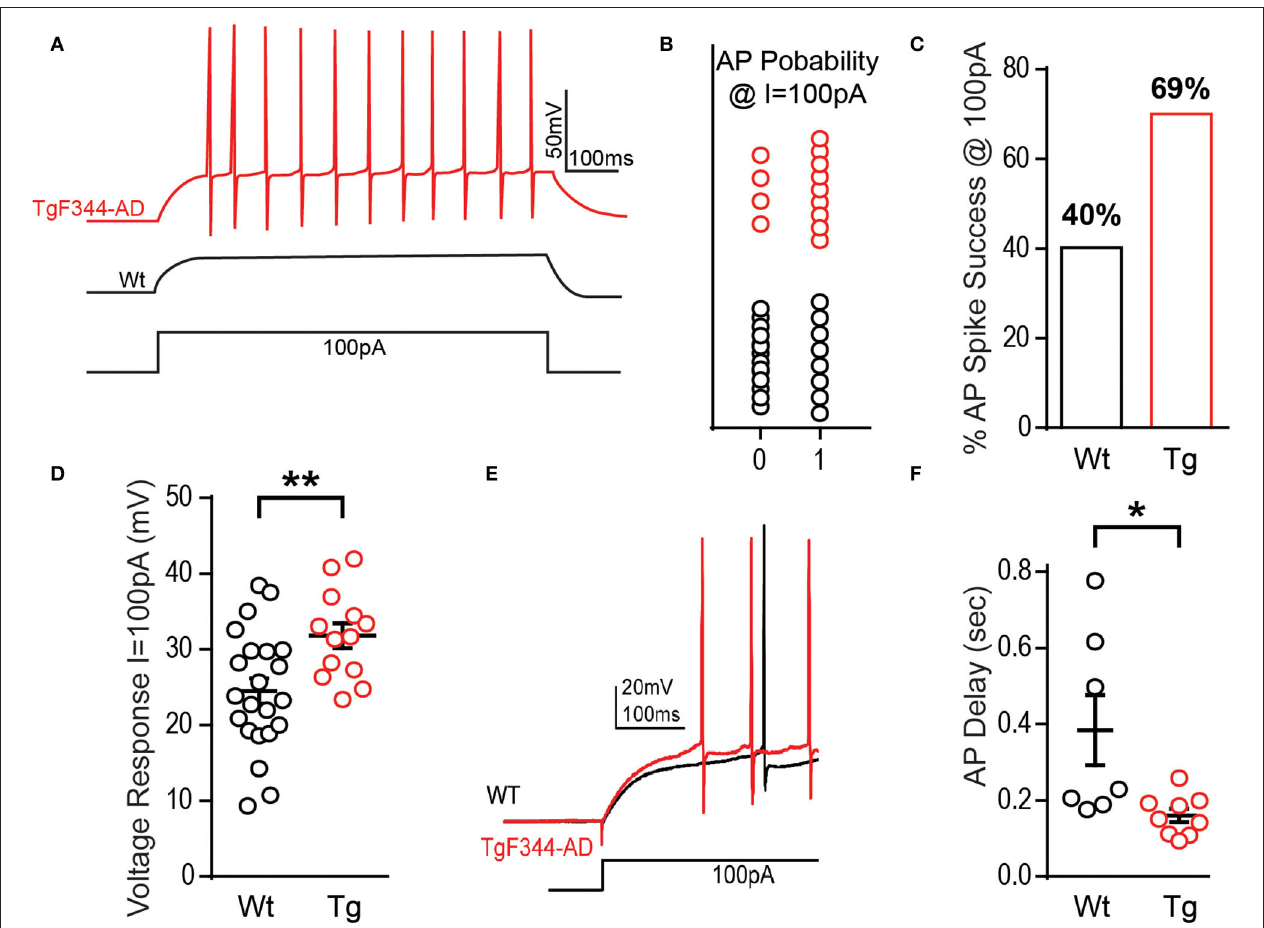
FIGURE 2 | TgF344-AD rats have a lower excitation threshold and fire sooner. (A) Example traces from a DGC recorded from a TgF344-AD and Wt littermate to illustrate that + 100pA depolarizing step can elicit action potentials more readily in TgF344-AD rats vs. Wt DGCs. (B) The probability of firing an action potential at + 100pA (0 = did not fire an AP, 1 = fired at least one AP) is greater in TgF344-AD DGCs (Wt 9/22 cells fired, Tg 9/13 cells fired). (C) DGCs from Wt rats discharged at + 100pA 40.9% of the time compared with a 69.2% success rate observed in TgF344-AD rats. (D) Regardless of whether the cell discharged or not, TgF344-AD DGC membranes have a greater voltage change (mV) compared with Wt during the first at + 100pA (Wt, n = 22 cells/8 animals; Tg, n = 13 cells/6 animals; ** p < 0.01). (E) Representative traces of the delay to fire the first action potential (Wt = black, Tg = red). (F) TgF344-AD DGCs had a decreased delay to fire during the first depolarizing current step at + 100pA (Wt n = 7 cells/5 animals, Tg n = 9 cells/6 animals; * p < 0.05). Data represent mean ± SEM. Significance is determined using the unpaired Student’s t